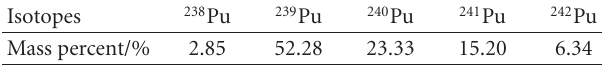
Table 1: The composition of reprocessed plutonium.